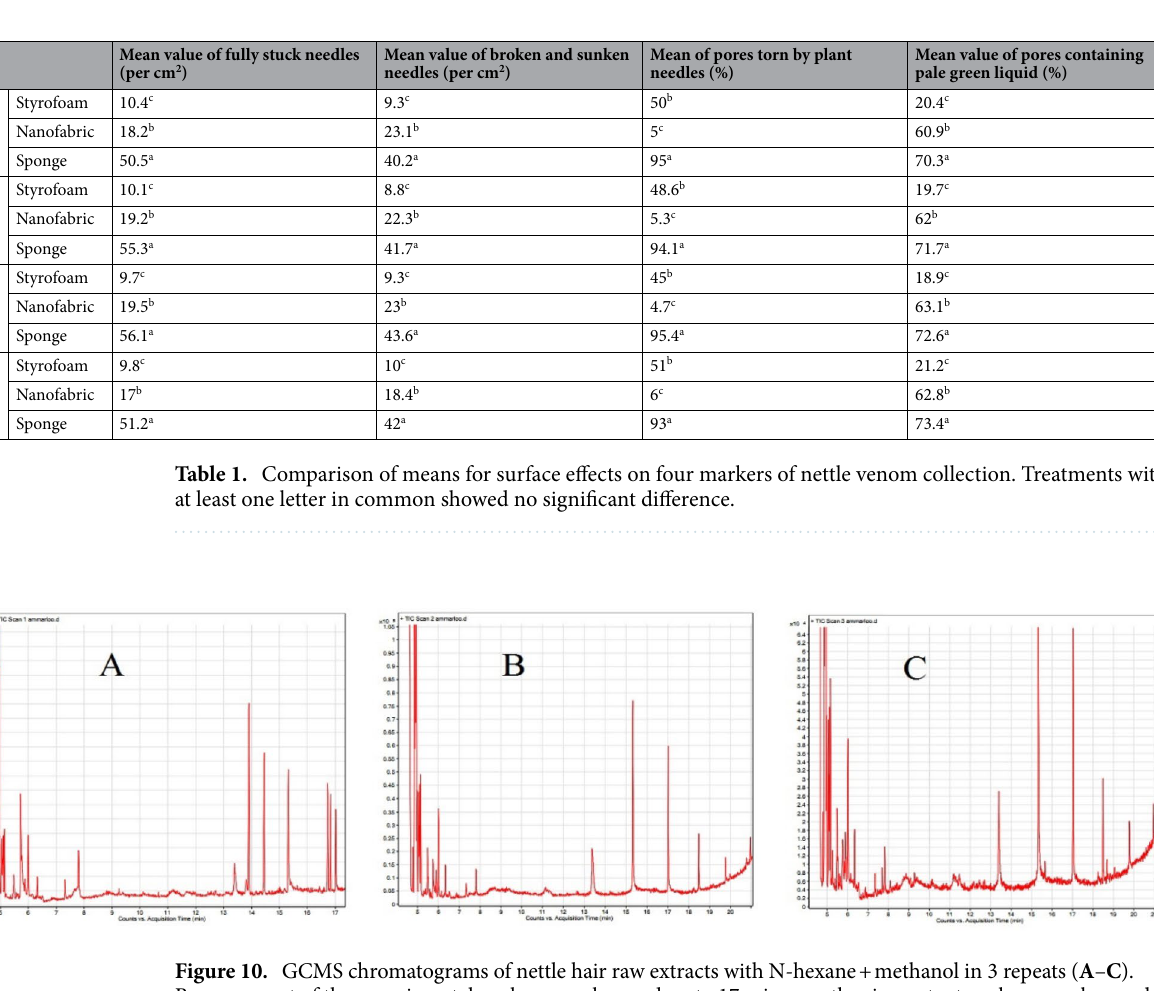
Mean of pores torn by plant needles (%)